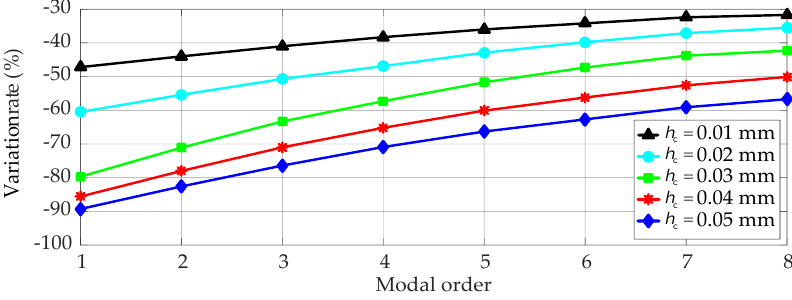
Figure 8. The variation rate of resonant response of the composite shell corresponding to different thicknesses of hard coating.